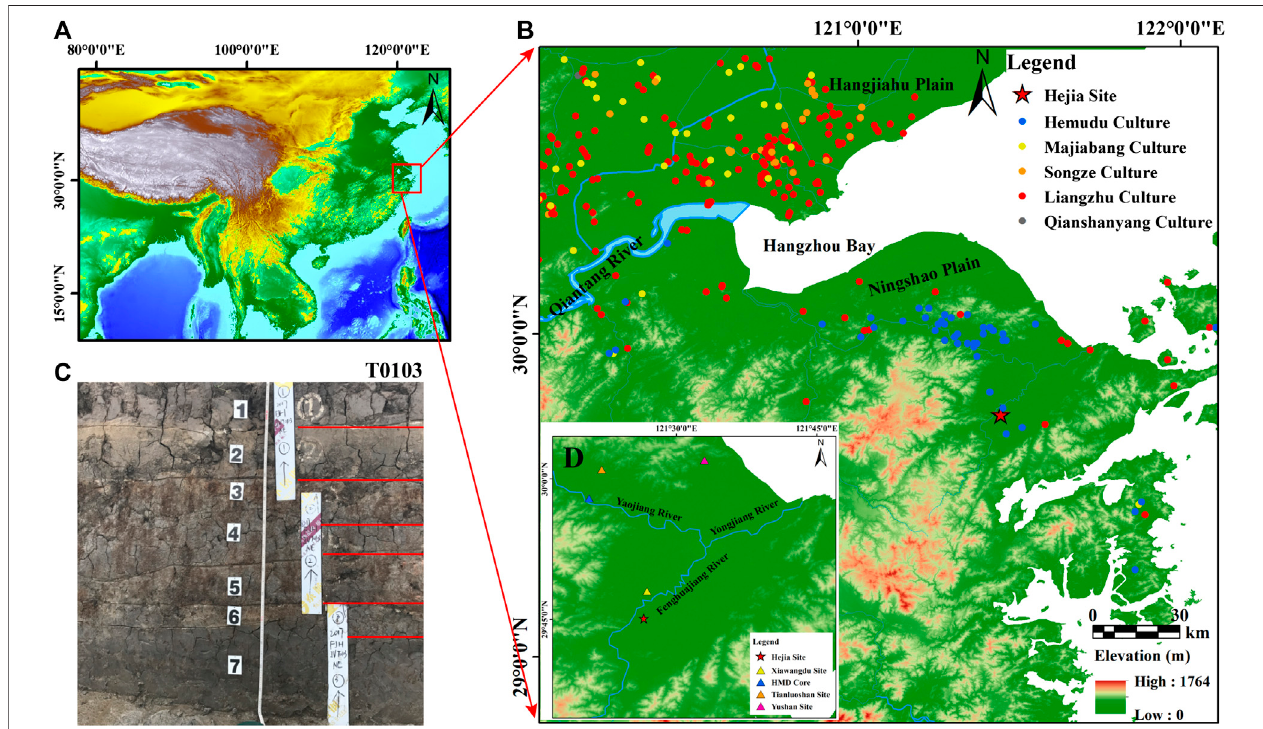
FIGURE 1 | Location maps and the photograph of the Hejia Site. (A) Location of the study area. (B) Location of the Hejia Site (red star) and the distribution of archaeological sites of the Hemudu Culture, Majiabang Culture, Songze Culture, Liangzhu Culture, and Qianshanyang Culture (Li et al., 2012; Liu et al., 2016; Luo and Zhao, 2019; He et al., 2020a). (C) The sampled pro fi le in the north wall of unit T0103 of the Hejia Site. (D) Distribution of core and key archaeological sites of Hemudu Culture.